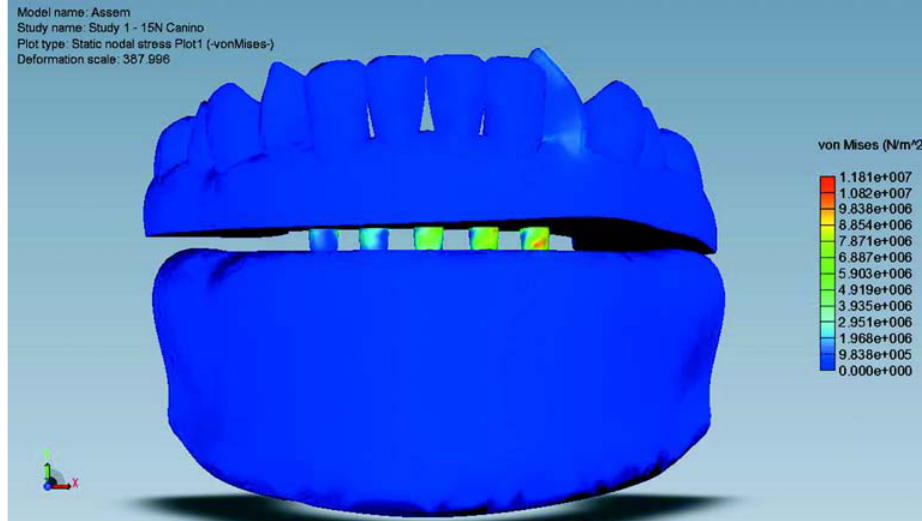
FIGURE 1- Disocclusion in canine